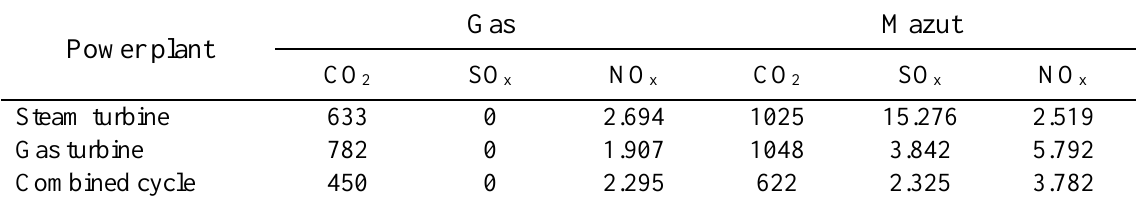
Table 5. Average pollutant emissions through electricity generation from various fuels in different power plants in Iran (gr/kWh) (Nazari et al., 2009).